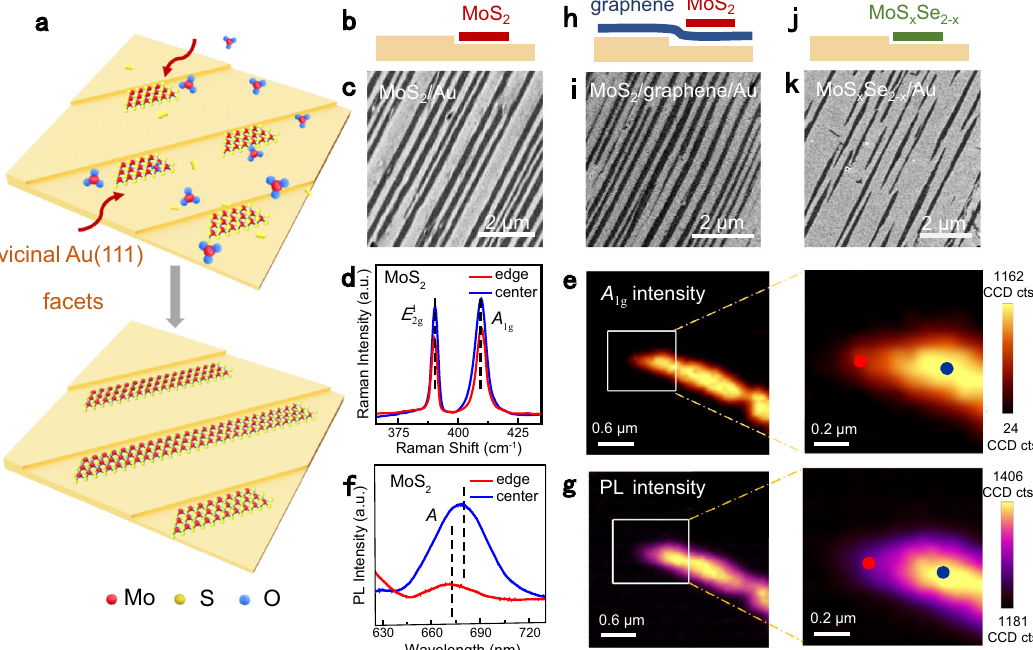
Fig. 2 Universal growth of aligned monolayer TMDs ribbons along the step edges of Au(111) vicinal facets. a Schematic illustration of the growth of well-aligned monolayer MoS 2 ribbons along the step edges of vicinal Au(111) facets. The red, yellow, and blue spheres represent Mo, S, and O atoms, respectively, and the red arrows indicate the diffusion pathways of the active species. b , c Schematic side view and SEM image of aligned monolayer MoS 2 ribbons grown on Au(223) facet, respectively. d Representative Raman spectra of the edges (red) and centers (blue) of monolayer MoS 2 ribbons transferred on SiO 2 /Si substrates. e Raman mapping on the intensity of A 1g peak for a MoS 2 ribbon. The right panel is the magni fi ed image of the white rectangle marked region in the left panel. The red and blue dots mark the edge and center positions of MoS 2 ribbon, respectively. a.u., arbitrary units. f , g Representative PL spectra of the edges (red) and centers (blue) of a MoS 2 ribbon and its PL mapping on the intensity of A peak. The right panel is the magni fi ed image of the white rectangle marked region in the left panel. The red and blue dots in ( g ) mark the edge and center positions of MoS 2 ribbon, respectively. h , i Schematic side view and SEM image of monolayer MoS 2 ribbons grown on monolayer graphene covered Au(213) facet, respectively. j , k Schematic side view and SEM image of monolayer MoS x Se 2-x ribbons grown along the steps of Au(235) facet,